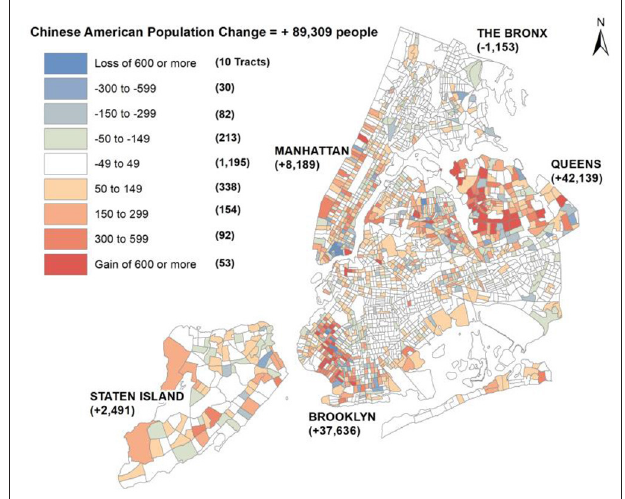
FIGURE 3 | Change in the Chinese American population from 2010 to 2016. Source: U.S. Census Bureau ACS 2010, 2016 ( 3, 4, 6).